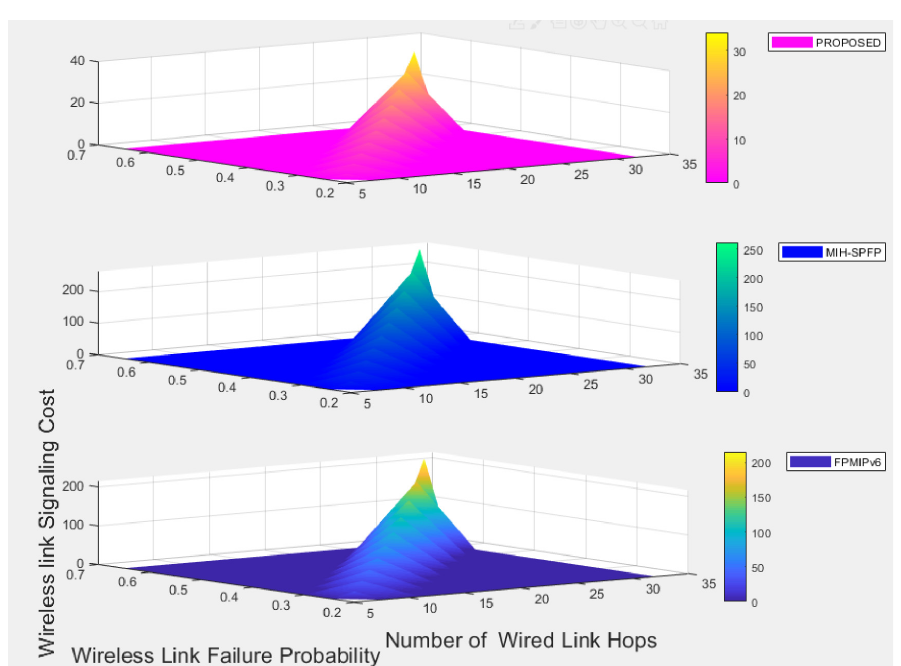
Fig 10. Wireless failure probability vs wireless link signaling cost.